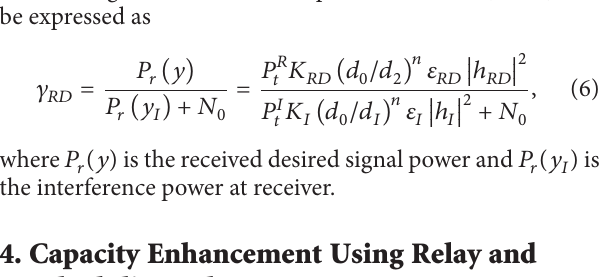
Table 1: Table maintained by 𝑅𝑥